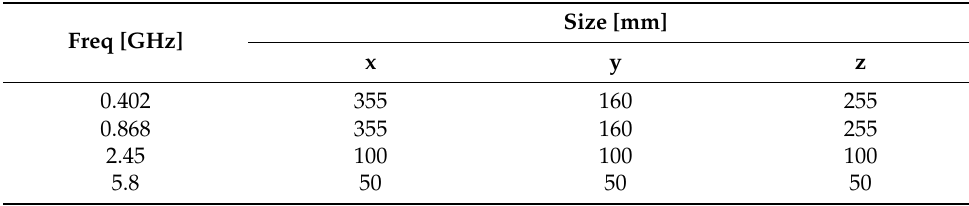
Table 2. Minimum phantom size that reliably represents an entire body for implant communication and EM attenuation for subcutaneous applications (0–10 mm insertion depth). The average absorption rate is the same as for deep implants.